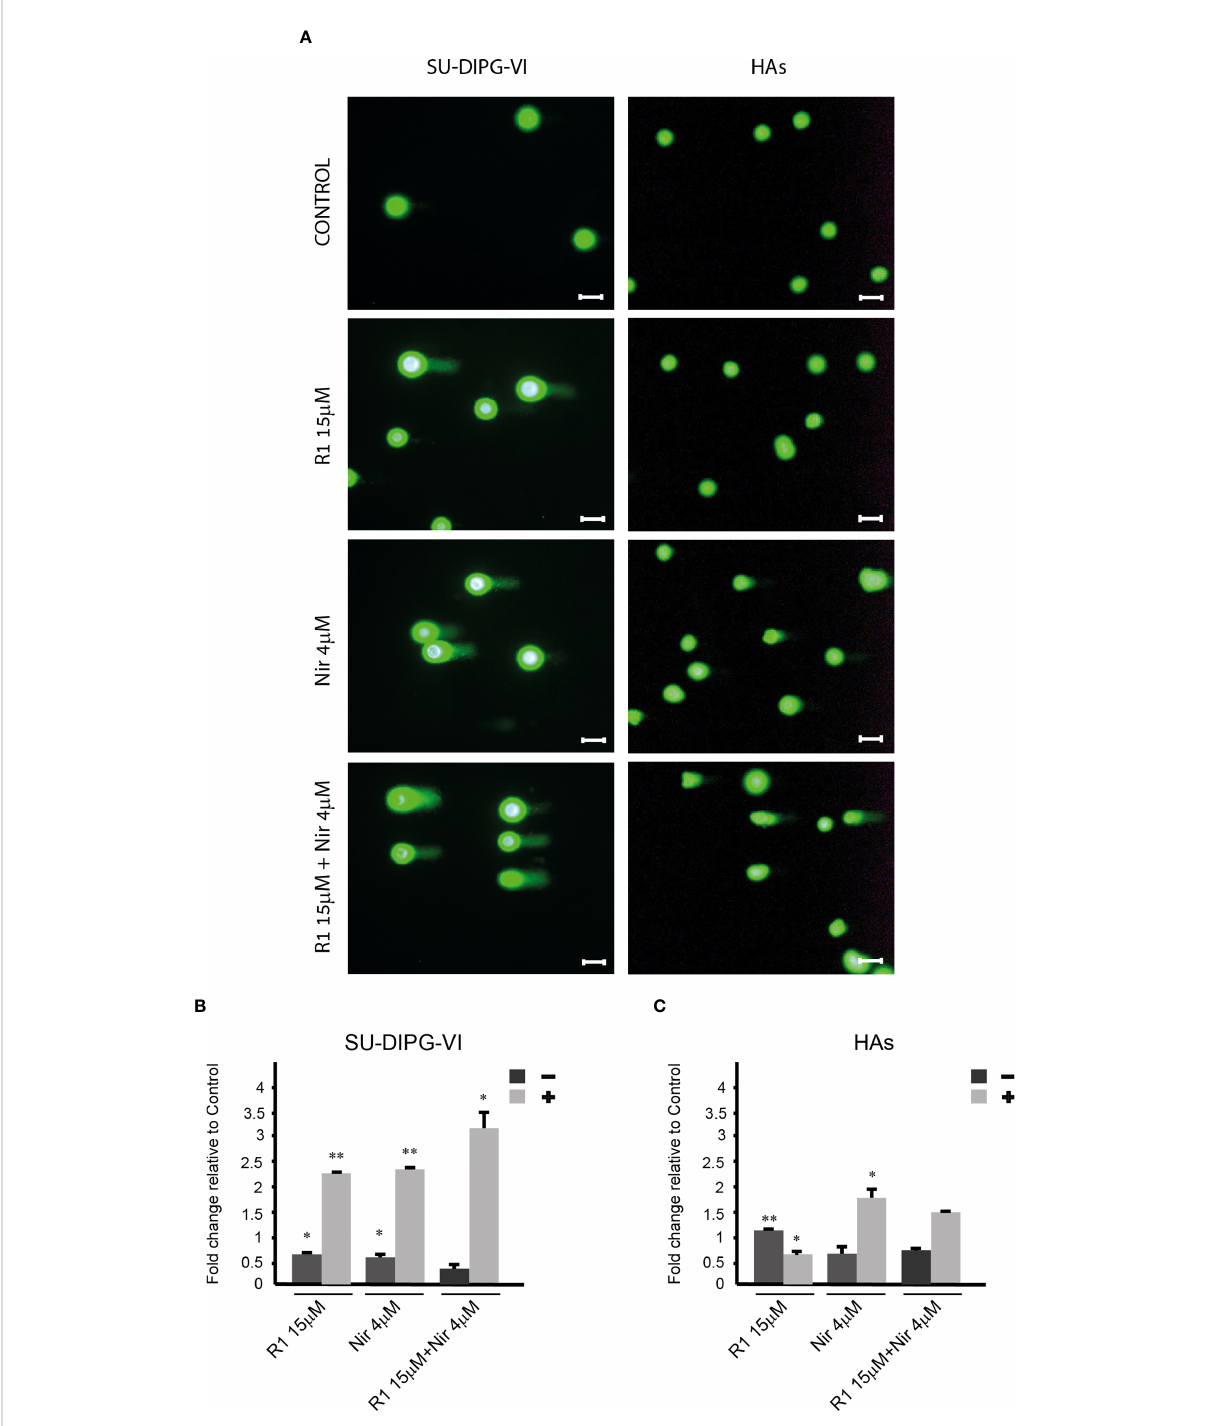
FIGURE 4 The effect of raphin-1, niraparib, and their combination on DNA integrity. SU-DIPG-VI and HAs cells were plated and treated with raphin-1, niraparib, and their combination for 48 h, before performing the comet assay. (A) . Images of SYBR Gold-stained cells. Bar, 100 µm. (B, C) . Treatment-induced changes in the fraction of cells with comets. Numbers are average ± S.D of fold change relative to control from two or three independent experiments (HAs and SU-DIPG-VI, respectively). When indicated, p-values denote signi fi cance of differences among all experimental groups, as well as between each experimental group and control — *p< 0.05, **p< 0.005. R1 — Raphin-1, Nir —